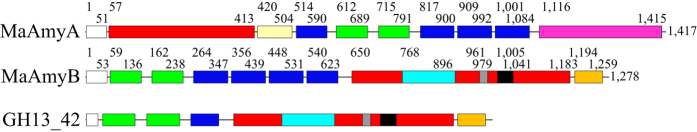
Detailed domain organization of MaAmyA and MaAmyB, compared to the general domain organization of GH13_42 members; numbers indicate the first and last aa of the domain or conserved insert.Domains are indicated as follows: white: signal sequence; red: AB-regions of the catalytic domain; pale yellow, C-region; blue: FNIII domain; green: CBM25 domain; pink: CBM74, a novel CBM domain15; orange yellow: aberrant C-region. Conserved insertions in the AB-regions of GH13_42 (including MaAmyB) are indicated as follows: light blue box: region-B; grey box: region-A insert 1; black box: region-A insert 2.